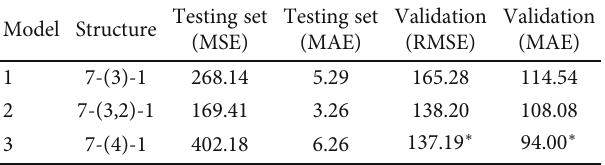
Table 2: Feed-forward neural network model selection. Table 3: Forecast data generated by the three neural network models.